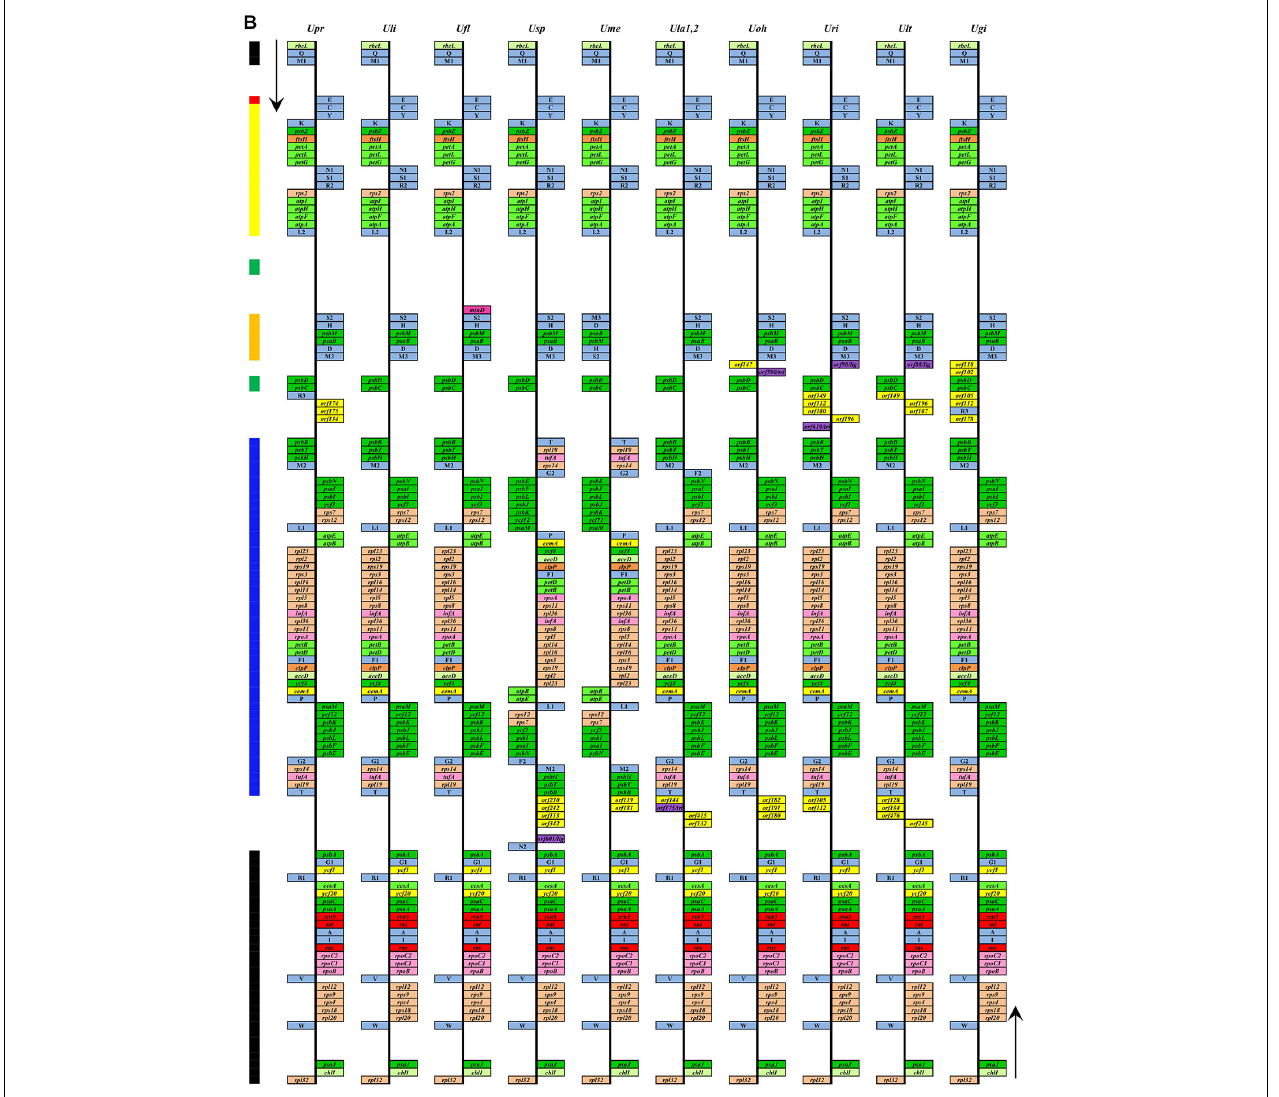
FIGURE 2 | Comparison of genome organization and gene order of the Ulva chloroplast genomes in Ulva lineage II (A) and lineage I (B) . Thick lines with different colors on the left represented different gene blocks. The arrows indicated the direction of gene transcription. Different gene types were shown as filled boxes in different